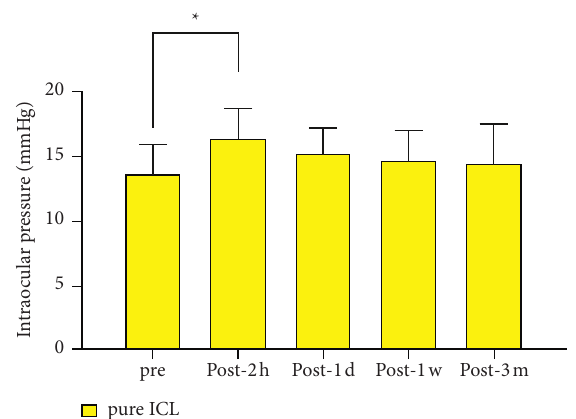
Figure 3: Time course of IOP changes in eyes undergoing pure ICL implantation. ∗ P < 0 .